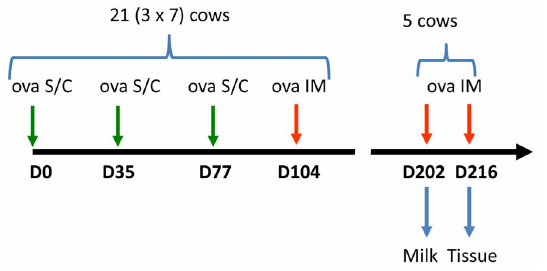
ovalbumin. Red arrows signal intramammary challenges with ovalbu-